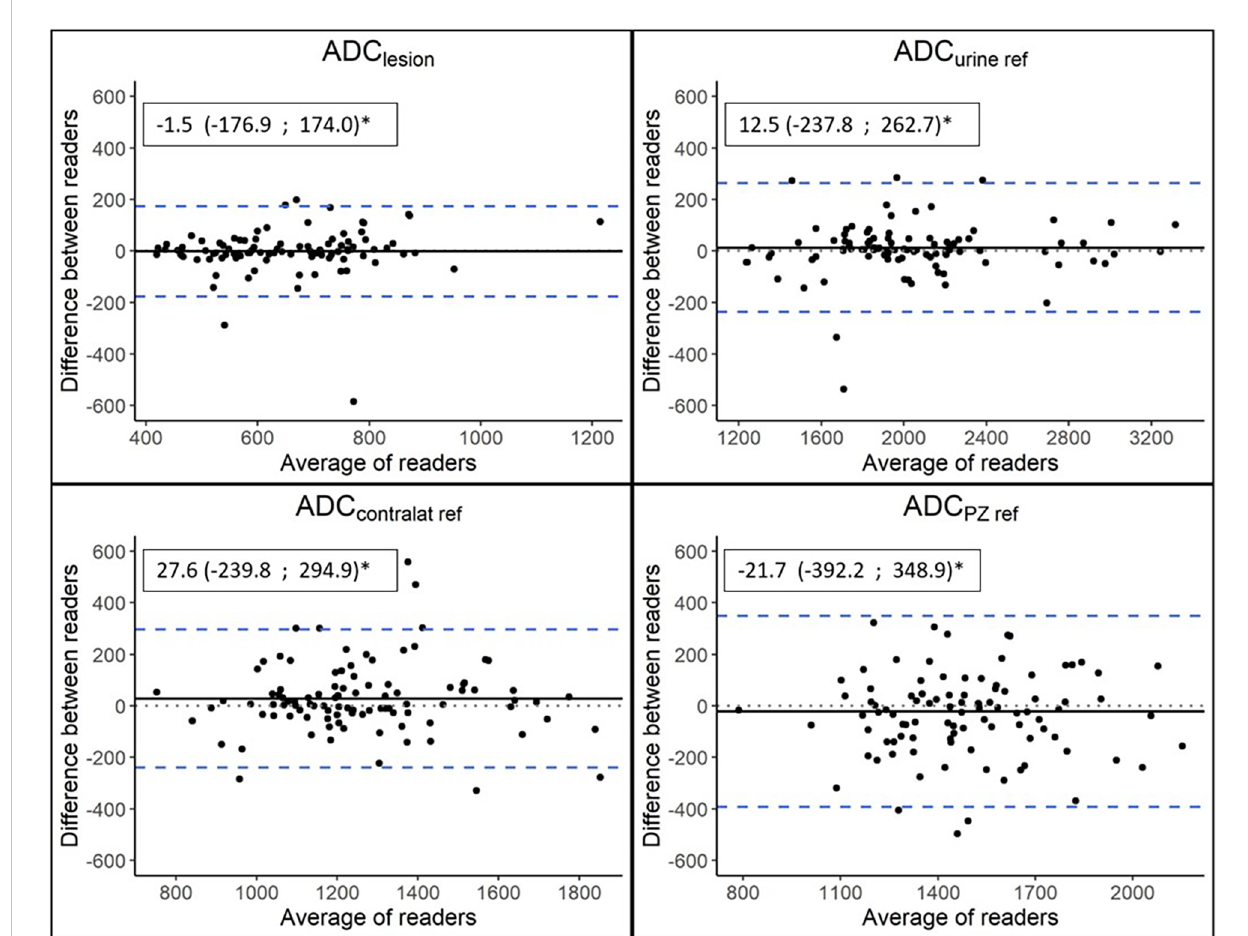
FIGURE 5 Bland-Altman plots. The dotted lines represent no difference between readers, the solid lines represent mean differences between readers, and the dashed blue lines represent limits of agreement, calculated as the mean difference ± 1.96SD of the mean difference. *Mean differences between readers (95% limits of